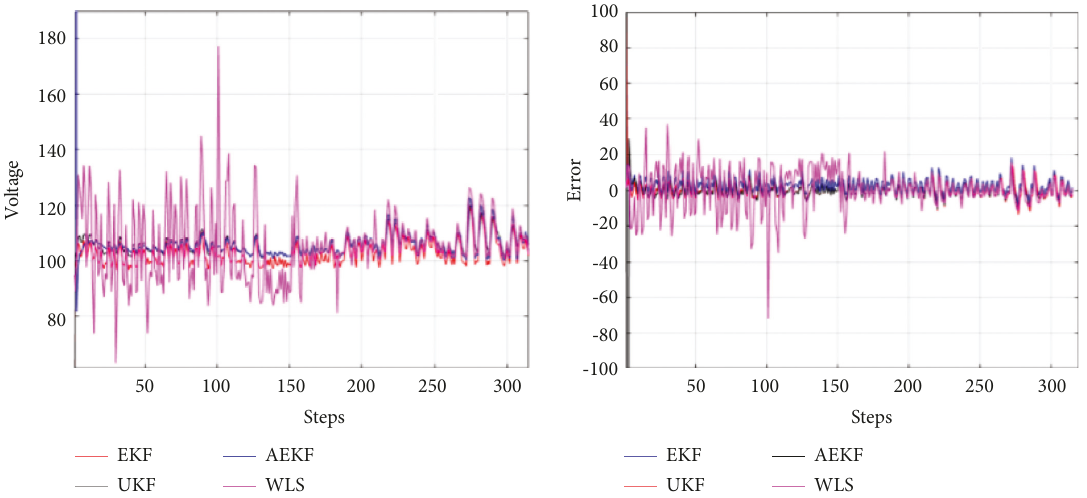
Figure 11: Comparison of estimators.